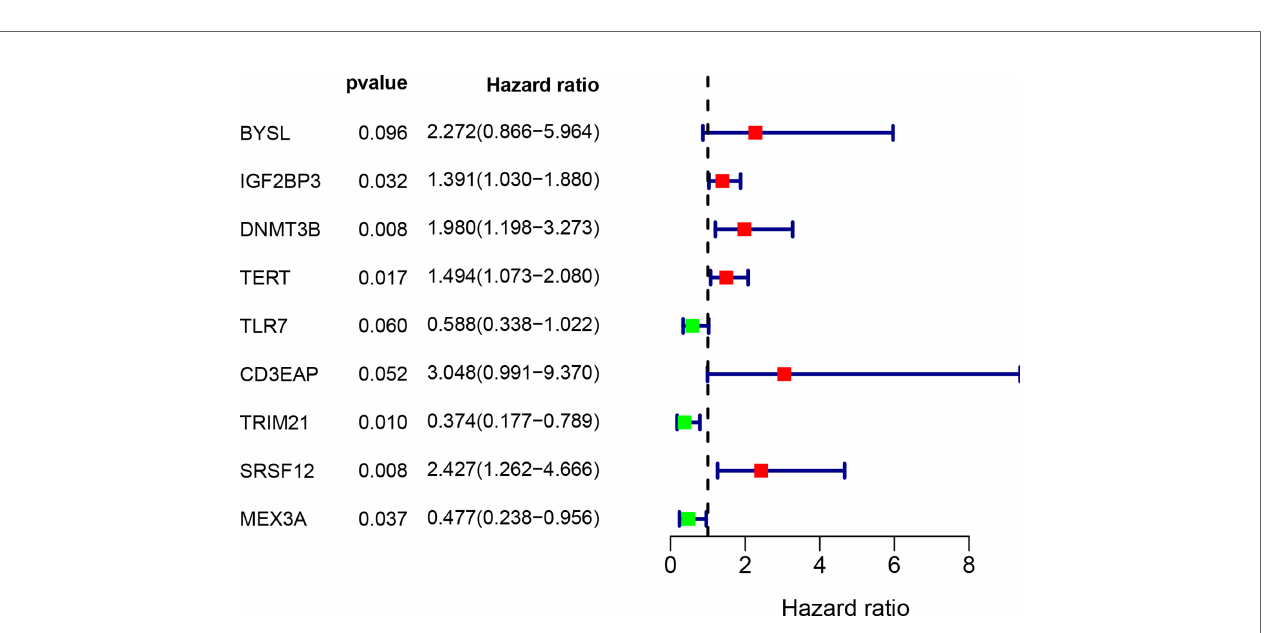
FIGURE 5 | Multivariate Cox regression analysis to identify prognosis related 9 hub RBPs. The forest plot of 9 hub RBPs based on multivariate Cox regression analysis. Red square, hazard ratio > 1; Green square, hazard ratio <